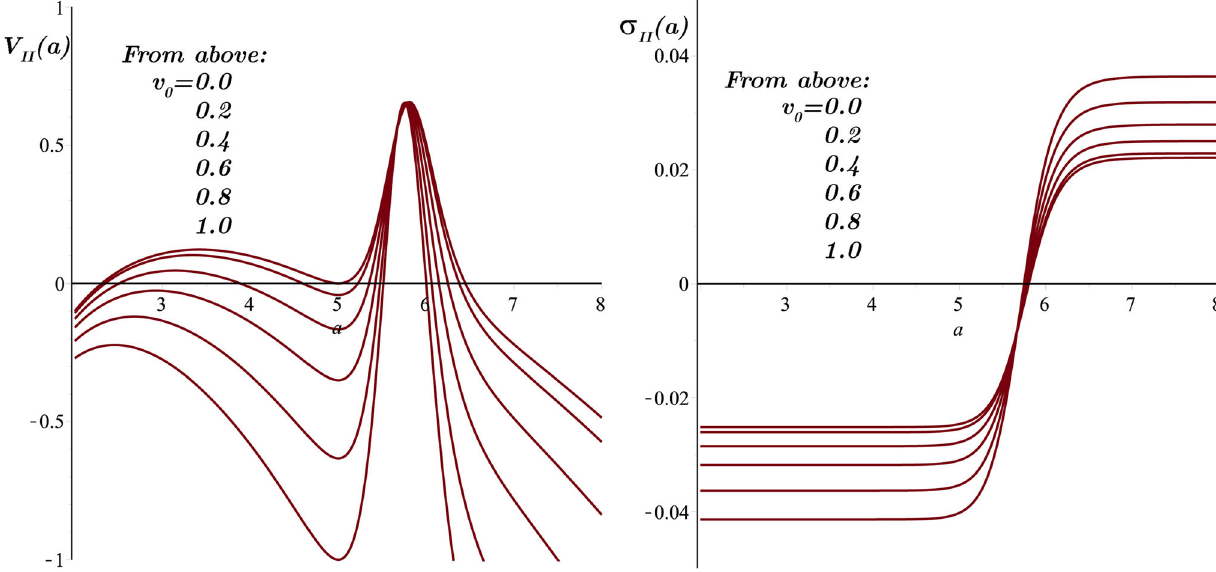
= − 16, M = 1 and from above v 0